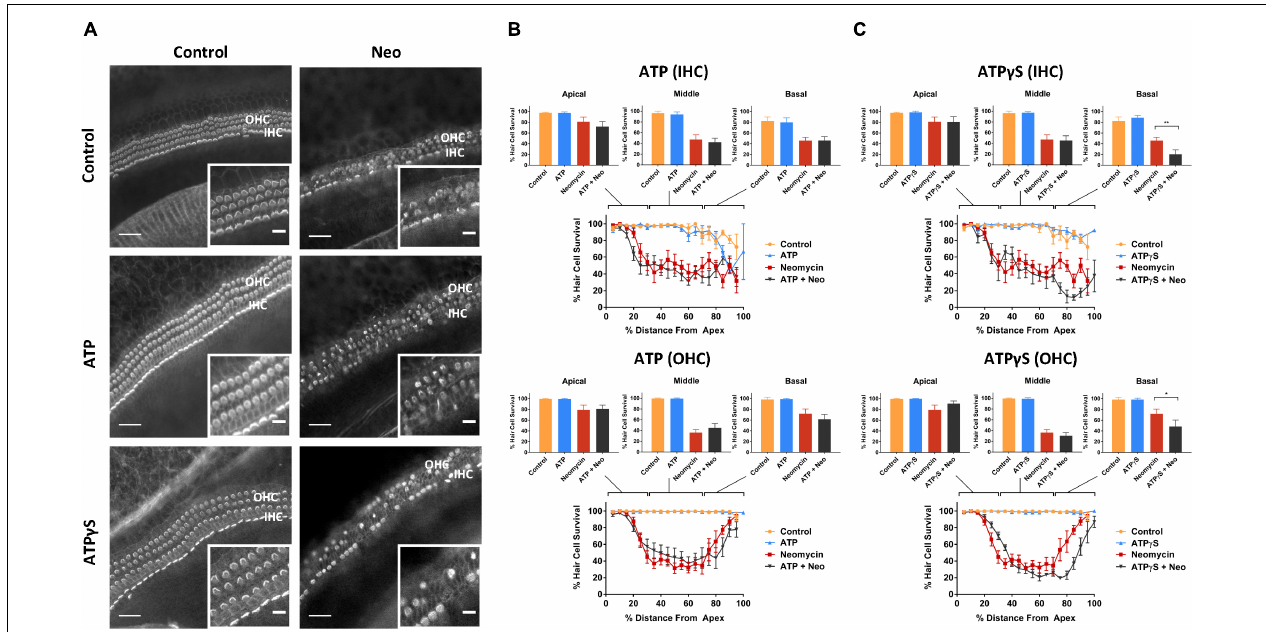
FIGURE 2 | Effect of ATP or ATP γ S supplementation on hair cell survival in the neomycin-treated mouse P3 organ of Corti explant. (A) Cochlear explants (basal segment) incubated in normal culture medium enriched with ATP or ATP γ S for 42 h with or without neomycin administration (1 mM, 3 h) in the middle of the timeframe. IHCs, inner hair cells; OHCs, outer hair cells. Scale bars: main, 30 µ m; inset, 10 µ m. (B) ATP (100 µ M) had no effect on the survival of IHC and OHC in normal culture medium or culture medium containing neomycin. Data presented as mean ± SEM (ATP, n = 7 and ATP + neomycin, n = 10). (C) In contrast, ATP γ